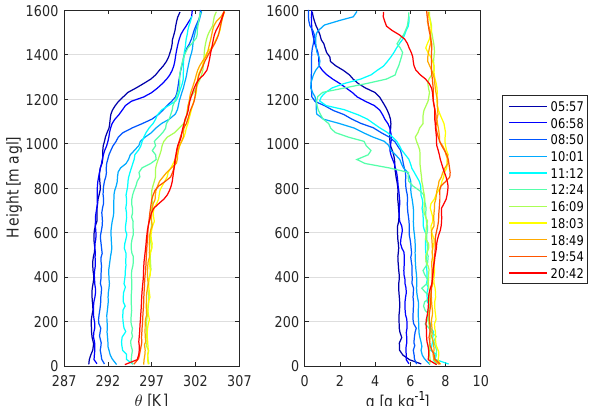
Figure 6. Profiles of potential temperature θ and specific humidity q measured by SUMO on 19 June 2011.